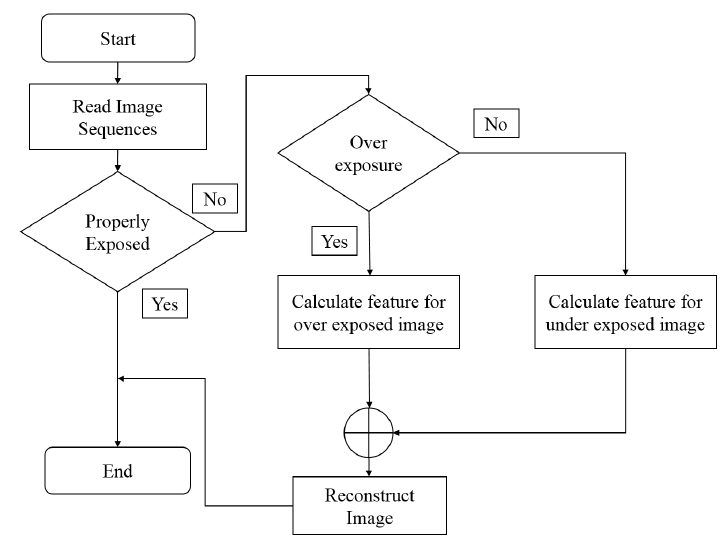
Figure 1: The flow chart of LCGHDR method